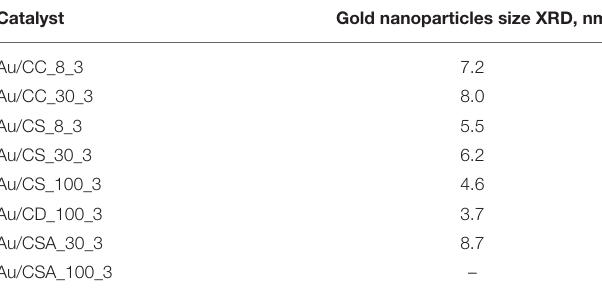
TABLE 7 | Average gold nanoparticles size for the Au/C catalysts. Catalyst